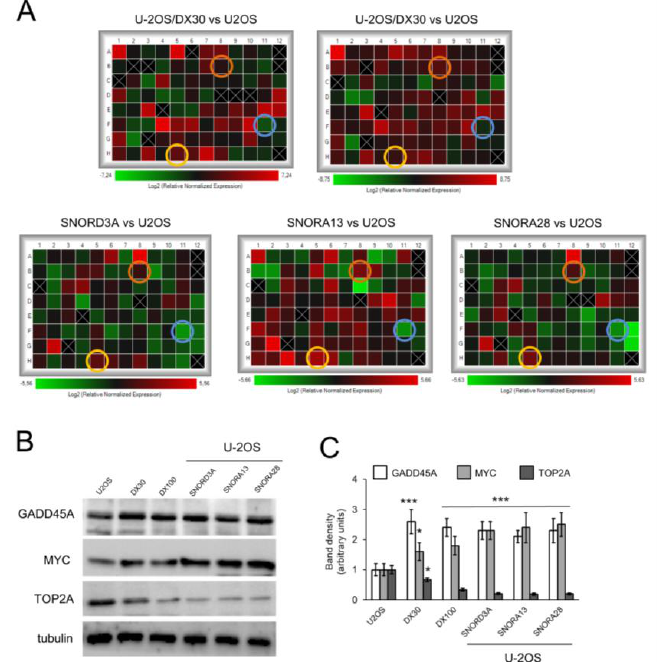
Figure 4. SNORD3A , SNORA13 and SNORA28 up-regulate GADD45A and MYC , downregulate TOP2A . U-2OS cells were transfected with empty vector (U-2OS) or expression vectors for SNORD3A , SNORA13 and SNORA28 . U-2OS / DX30, U-2OS / DX100 and U-2OS / DX580 cells were used as control of Dox-resistant cells. ( A ) Heatmaps of changes in the expression of genes relevant for osteosarcoma pathogenesis and progression, measured by PCR arrays ( n = 4). Yellow circles: GADD45A hits; orange circles: MYC hits; blue circles: TOP2A hits. ( B ) Immunoblot of the indicated proteins. The figure is representative of one out of three experiments. Tubulin was used as control of equal protein loading. ( C ) Immunoblot quantitation. The quantitation of the band density was performed using the ImageJ software. Data are means + SD ( n = 3). * p < 0.05, *** p < 0.001: U-2OS / DX30, U-2OS / DX100